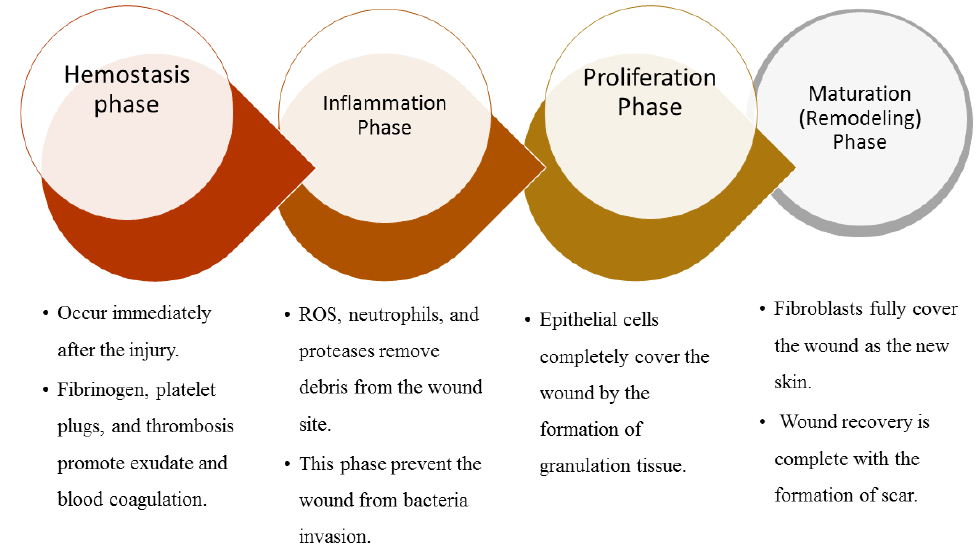
Figure 2. Phases of wound healing.